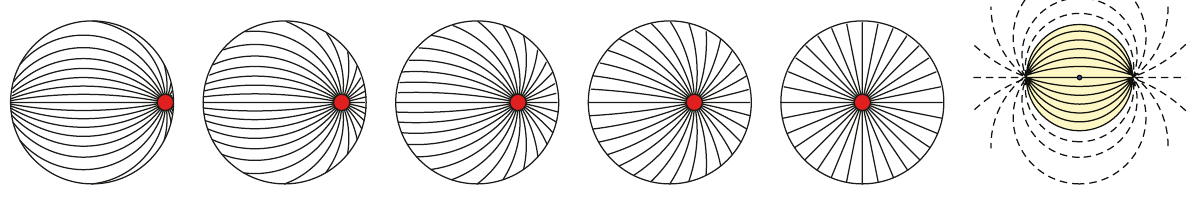
Figure 9: Circular paths are paths formed by the circumferences of circles which cross the unit disk at the opposite points.